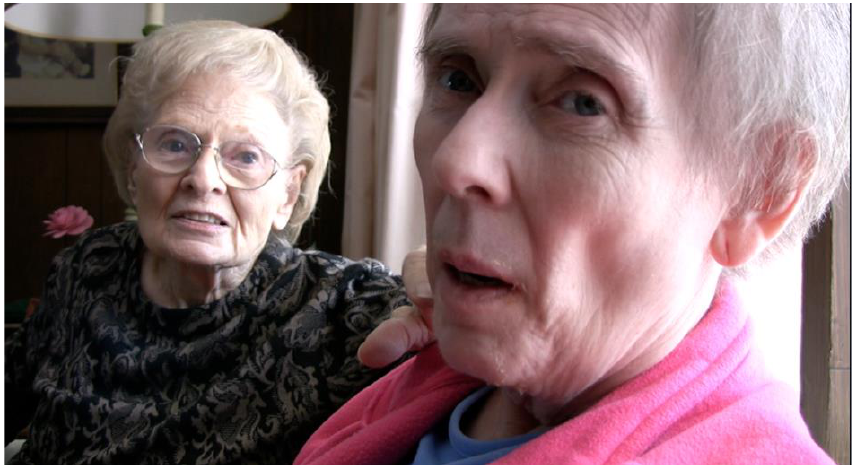
Figure 7: Mimi and Dona after Dona’s move to the Denton State School. Courtesy: Sophie